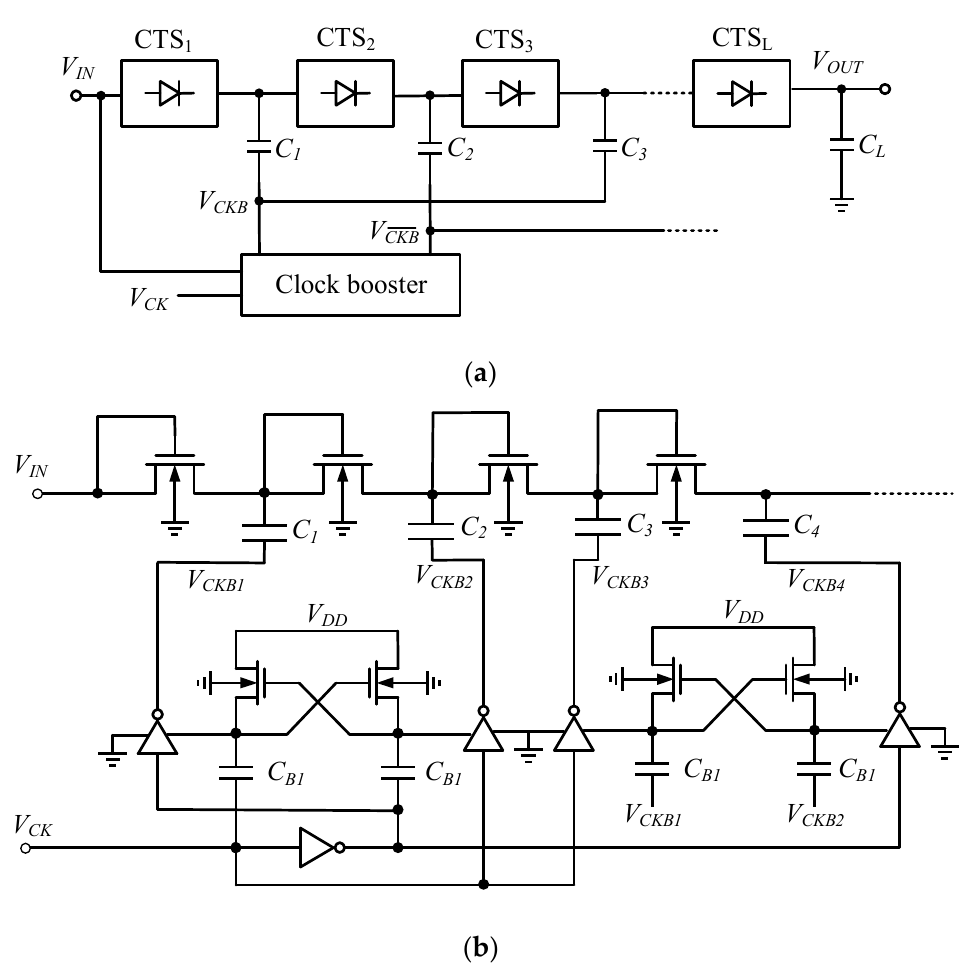
Figure 6. Clock-boosted CP: ( a ) simplified scheme; ( b ) multi-stage scheme.